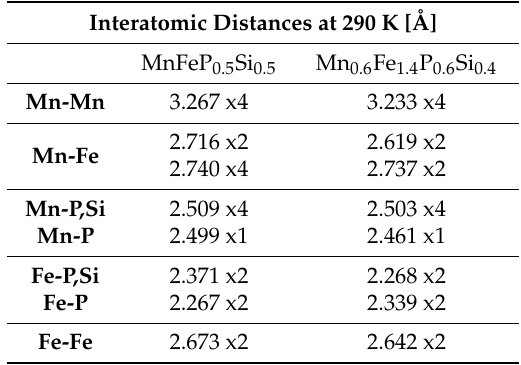
Table A2. A comparison of interatomic distances for MnFeP 0.5 Si 0.at temperatures apart T C .